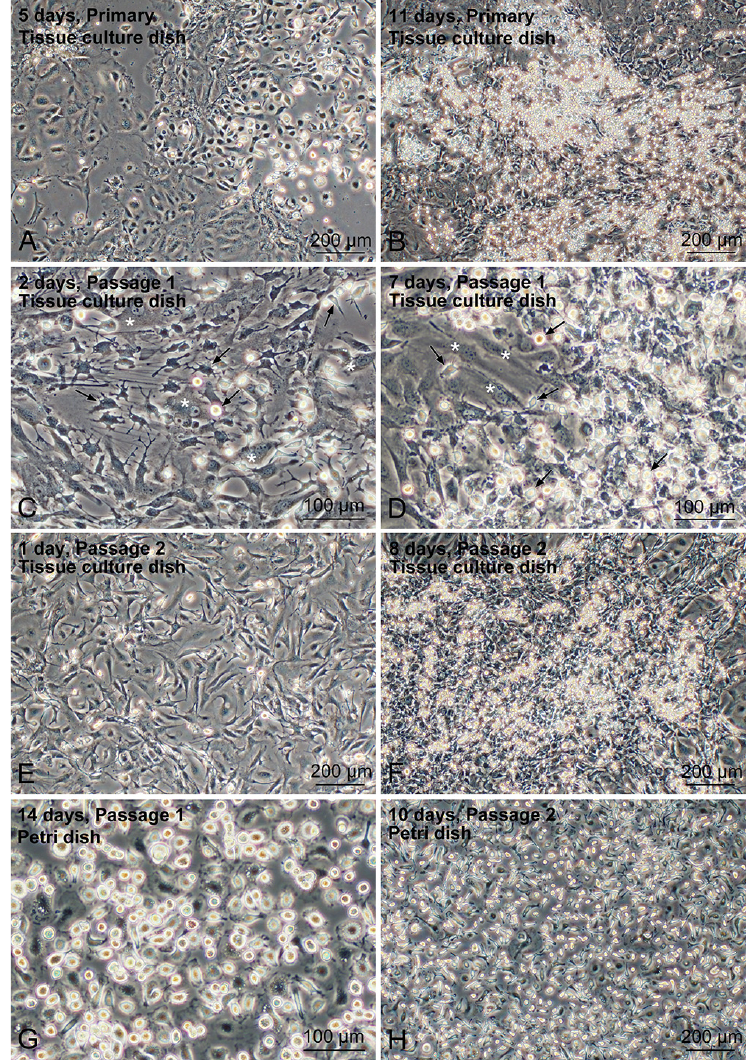
Figure 1. Phase-contrast micrographs showing the propagation of liver tissue-resident Mø in the mixed-culture as well as sub-culture with hepatic non-parenchymal cells in tissue-culture dishes and their segregation in bacteriological Petri dishes. ( A , B ) Primary liver cells were cultured for the indicated days after seeding in a tissue culture dish. ( C , D ) Liver cells after passage 1 were conducted on the indicated days after seeding in a tissue culture dish. The cells are mostly composed of non-parenchymal fibroblastic cells (*) and Mø (arrows). ( E , F ) Hepatic non-parenchymal cells after passage 2, on indicated days after seeding in a tissue culture dish. ( G , H ) Liver tissue-resident Mø in bacteriological Petri dishes. Nonadherent cells that formed cell aggregates were removed by washing with a conditioned medium. Mø selectively adhered to the surface of the dish.